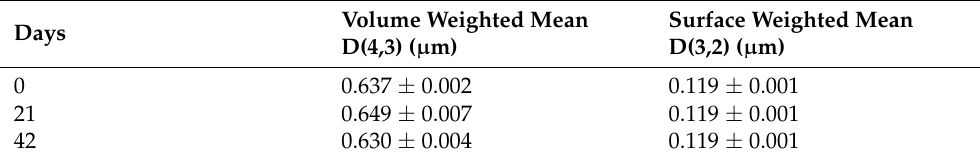
Figure 1. ( A ) Optical microscopy of the high ‐ sheared emulsion (Scale bar: 10 μm ); ( B ) SEM image Figure 1. (A) Optical microscopy of the high-sheared emulsion (Scale bar: 10 µ m); (B) SEM image of of the freeze ‐ dried encapsulated powder containing DGM. the freeze-dried encapsulated powder containing DGM. Table 2. Particle size characteristics for o/w DGM-inulin emulsion stored at 4 ◦